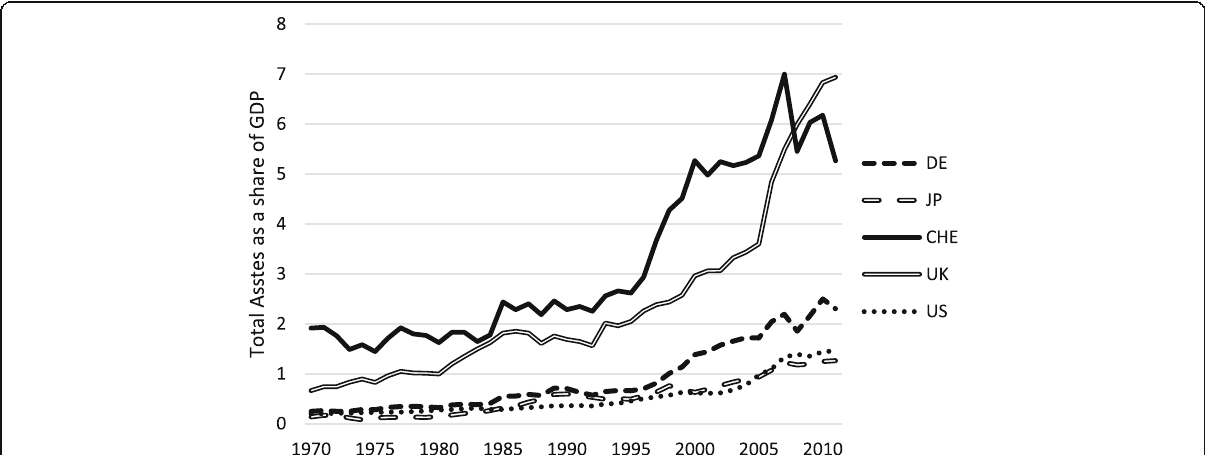
Fig. 5 Gross foreign assets as a share of GDP. Sample: 1970 – 2011, Source: External Wealth of Nations, Lane and Milesi-Ferretti (2007), updated dataset